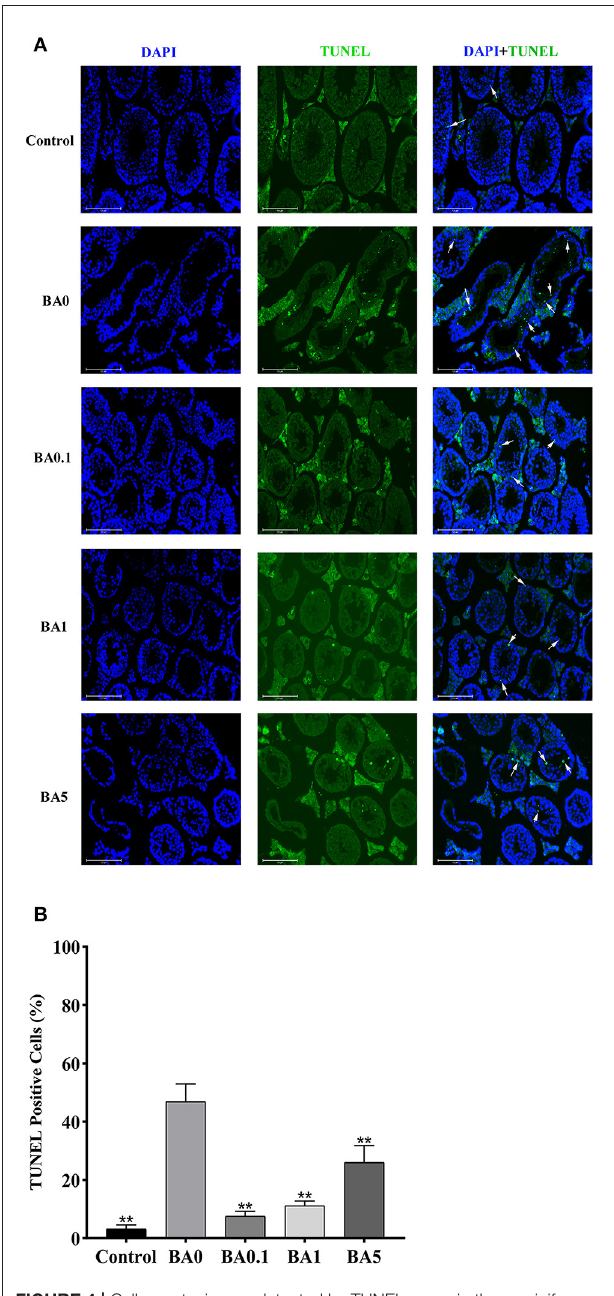
FIGURE 4 | Cell apoptosis was detected by TUNEL assay in the seminiferous tubules in the control and different treatment groups. (A) The representative images of TUNEL staining. Blue means nuclei stained with DAPI, while green means TUNEL-positive cells stained with TUNEL, white arrows show apoptotic cells, scale bar = 125 µ m. (B) The percentage of TUNEL-positive cells. TUNEL-positive cells (%) were calculated by the number of positive cells divided by the total number of cells **p < 0.01.